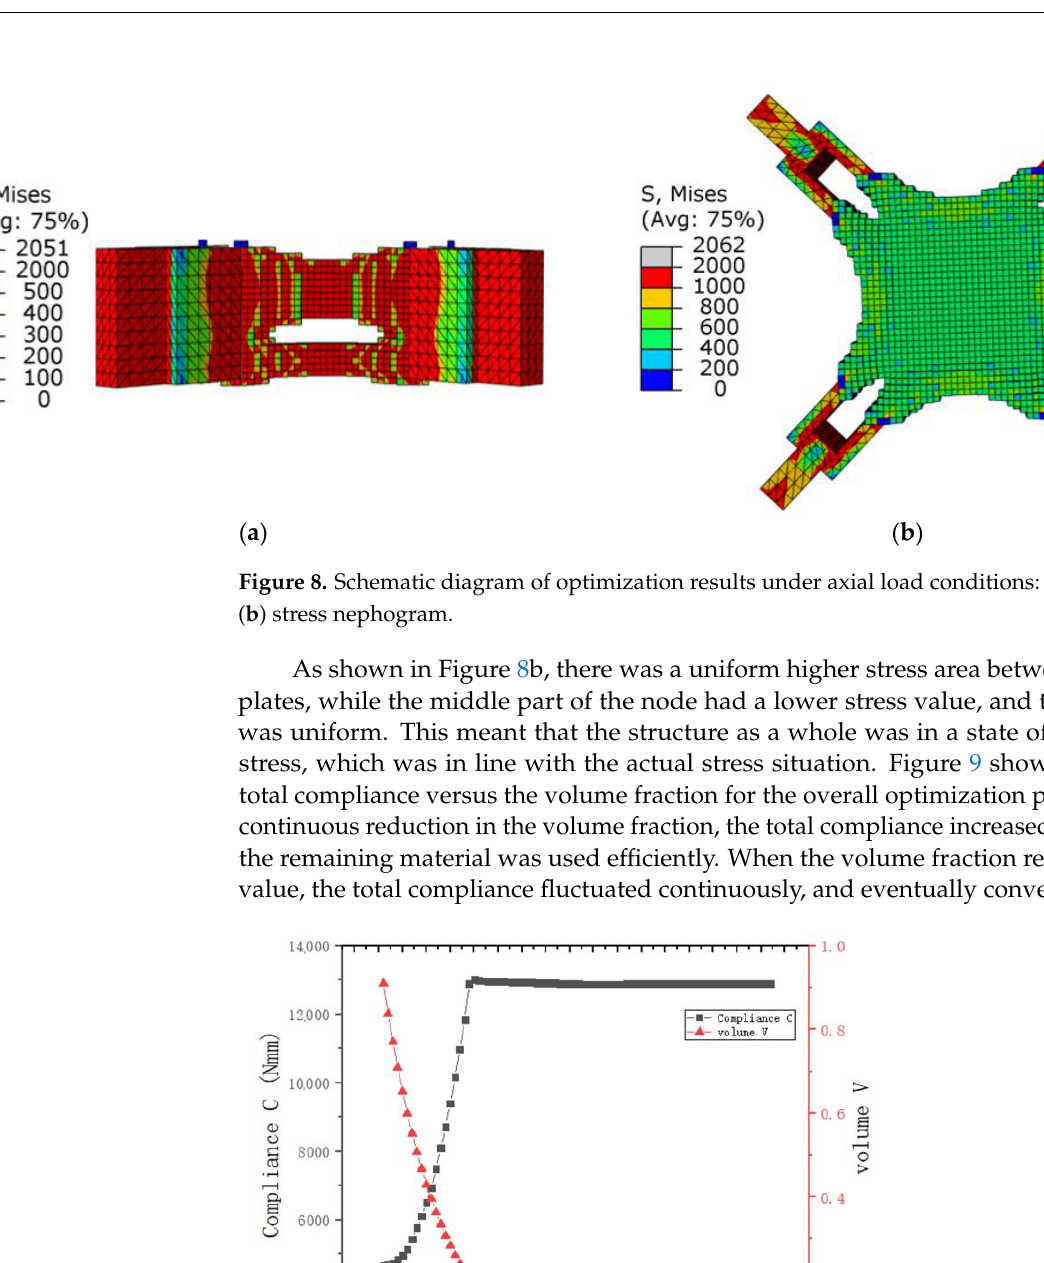
( b ) Figure 10. Schematic diagram of optimization results under shear conditions: ( a ) lateral view; ( b ) stress nephogram. From the point of view of the stress distribution, the maximum value appeared at the connection between the node and the ear plate. After optimization, the overall stress dis- tribution of the structure was uniform, indicating that the overall structure was in a highly efficient state of stress. In Figure 11, as the volume fraction continued to decrease, the average flexibility increased until the target volume fraction was reached, and the flexi- bility value began to converge. This purpose of this stage was to continuously optimize the element distribution without changing the target volume. The flexibility value gradu- ally converged accurately, and finally, the optimized optimization results were obtained.